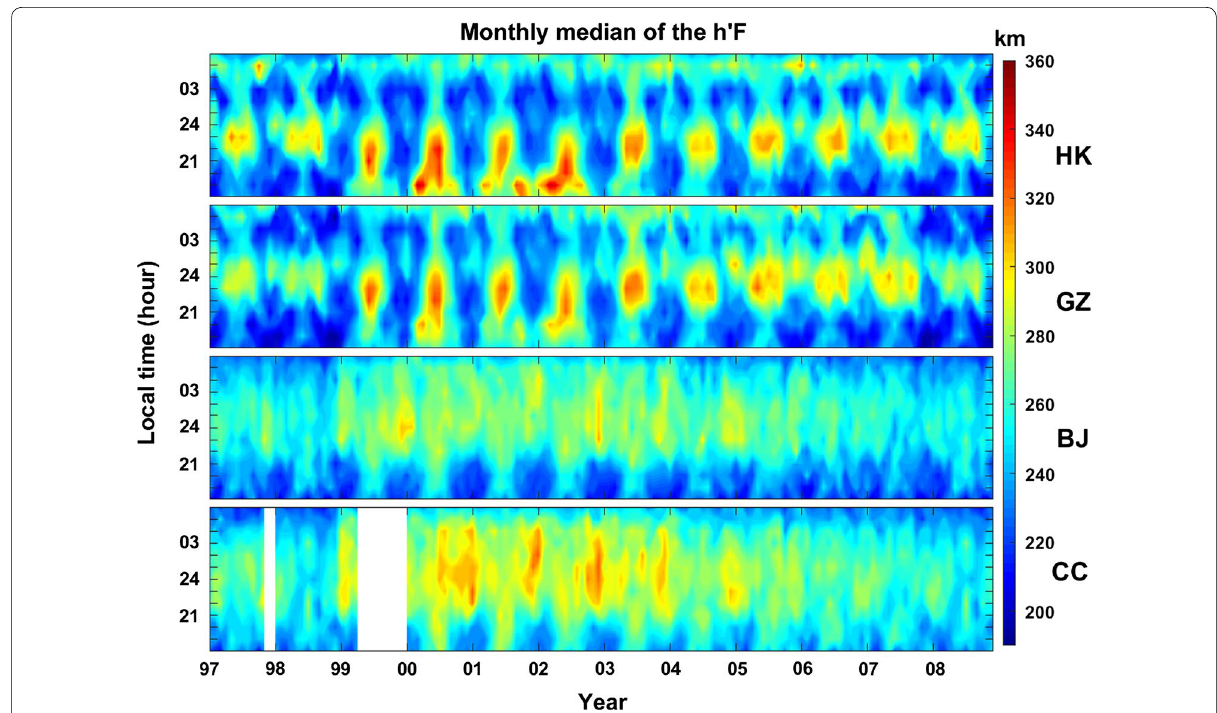
Fig. 10 Same as Fig. 6, but for monthly medians of the h ′ F